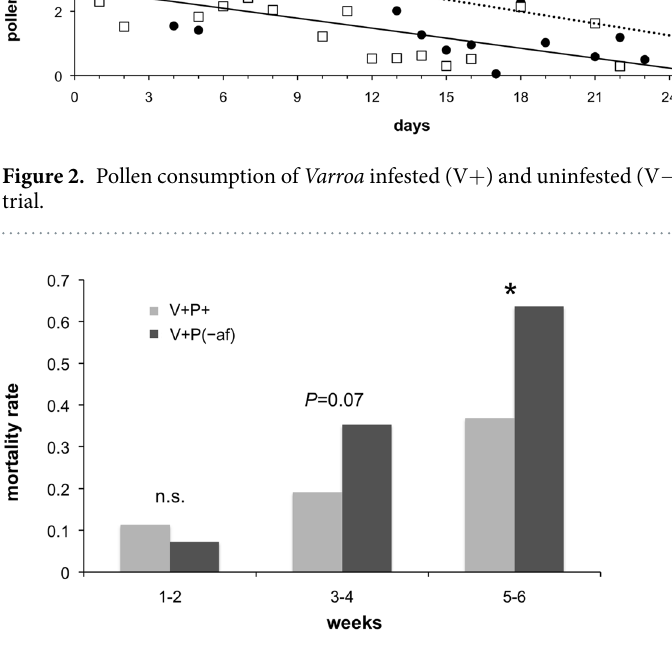
Figure 3. Mortality of the Varroa infested bees fed with a complete pollen diet (V + P + ) and with pollen without apolar fraction (V + P( −